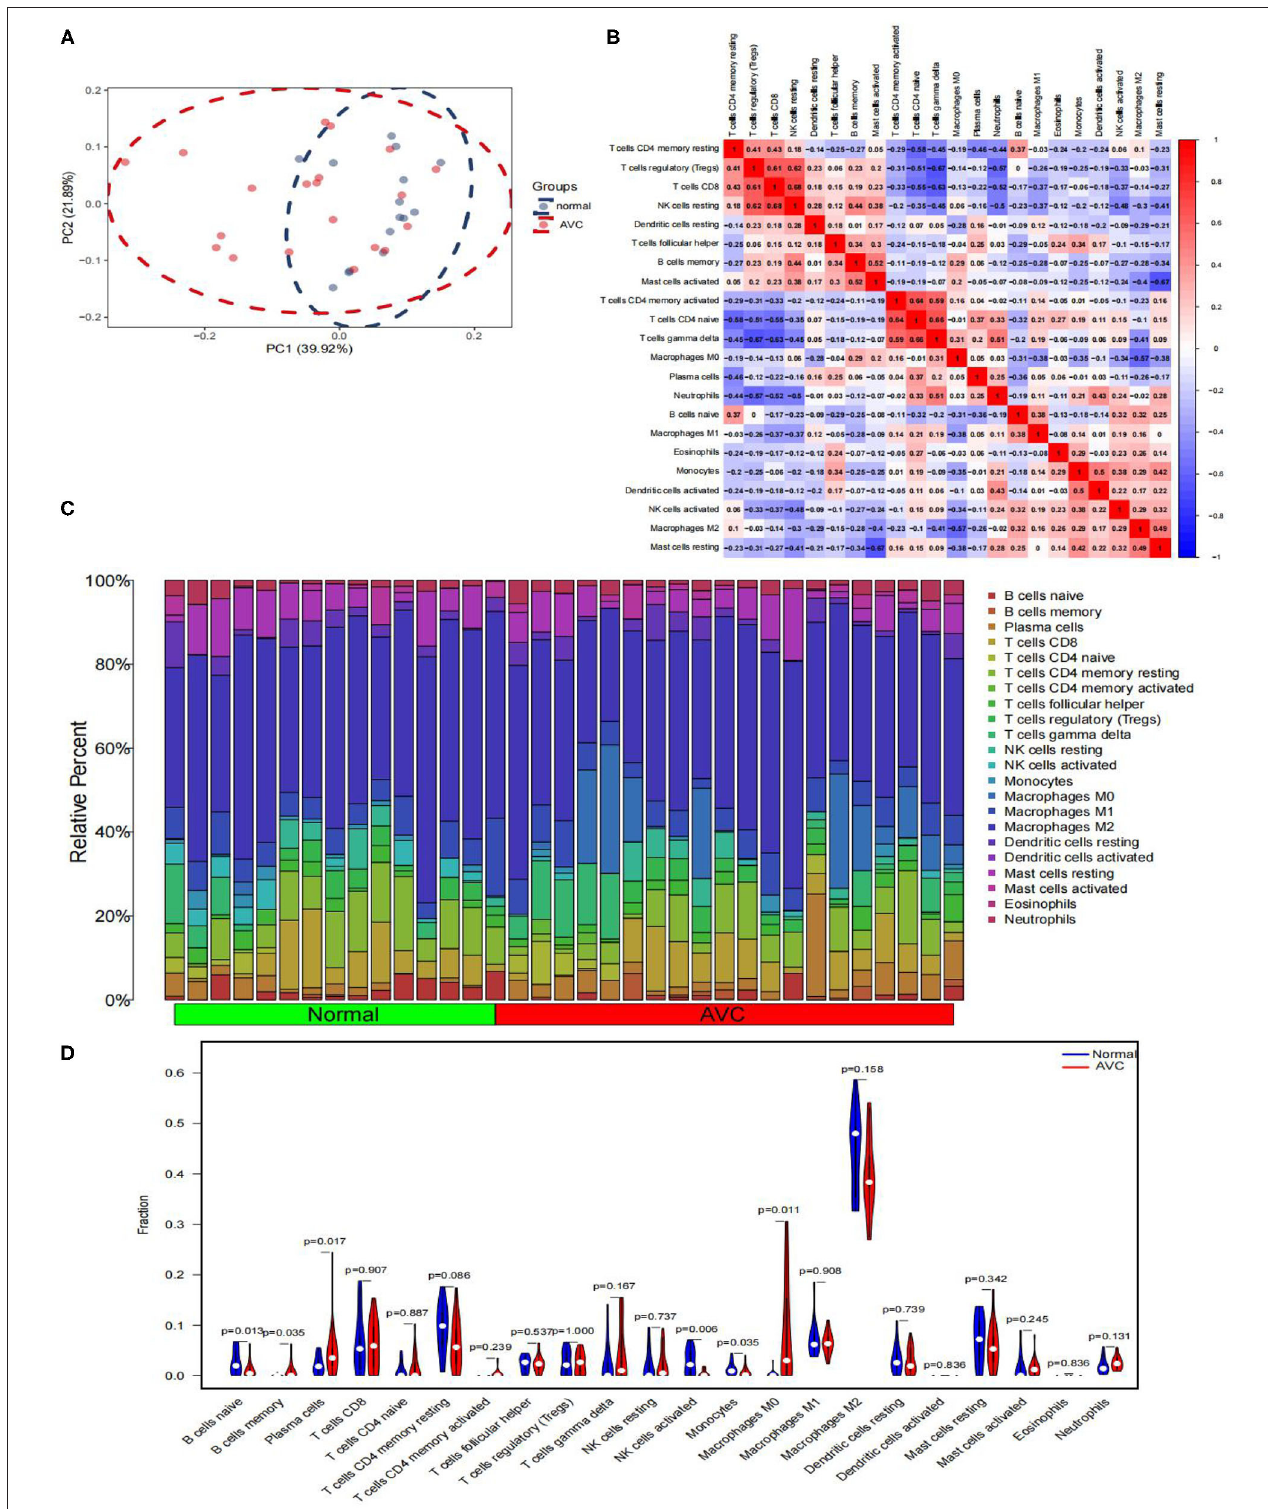
FIGURE 9 | Comparing the composition of immune cell infiltration in the normal and AVC samples by using the combined data matrix of GSE12644 and GSE51472 and visualized the results. (A) PCA cluster plot of immune cell infiltration between normal and AVC groups. (B) Correlation heat map of 22 types of immune cells. The size of the colored squares represents the strength of the correlation; red represents a positive correlation, blue represents a negative correlation. The redder the color, the stronger the correlation. (C) The heat map of the 22 subpopulations of immune cells. (D) Violin diagram of the proportion of 22 types of immune cells. (The normal controls group was marked as blue color and AVC group was marked as red color. P -values < 0.05 were considered as statistically